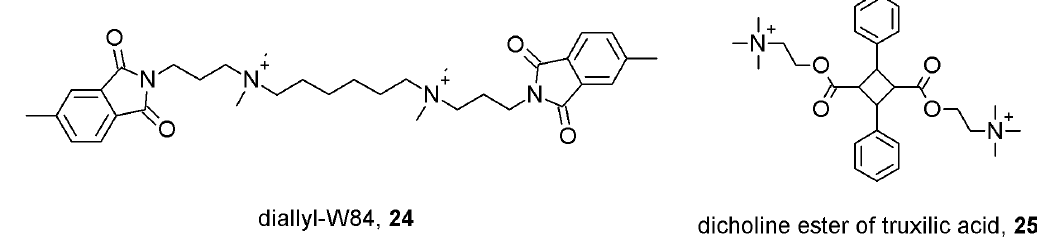
Figure 6. Structures of radiolabeled allosteric modulators of muscarinic